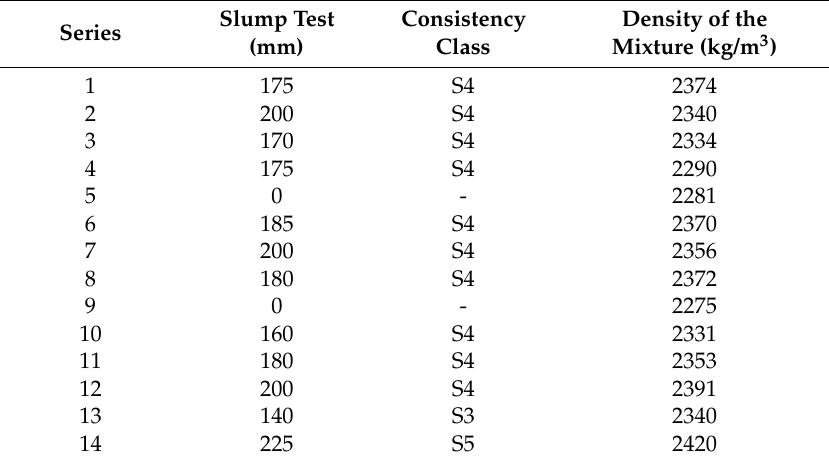
Table 8. Results of fresh concrete mixtures .